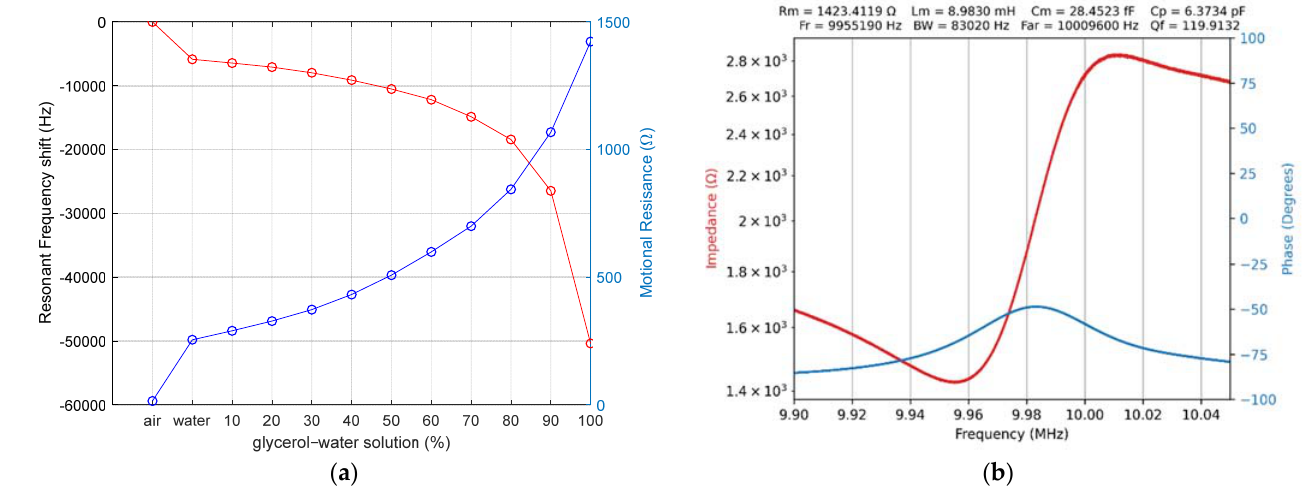
Figure 5. The virtual impedance analyzer (VIA): ( a ) series frequency resonance shift and motional resistance from air, water, and glycerin–water solution, ( b ) QCM sensor in 100% glycerin.